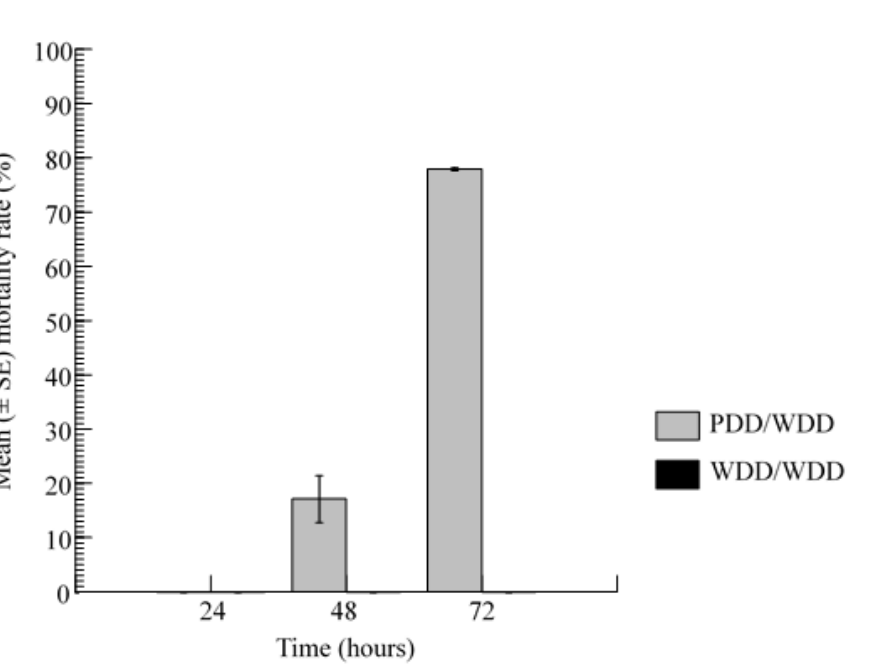
Figure 5. Mortality rates of the house flies when they were placed in two different environments: one enclosure containing an assorted pair of floral designs (one PDD with toxic sugar and a WDD with non-toxic sugar) and a control enclosure containing two WDDs.